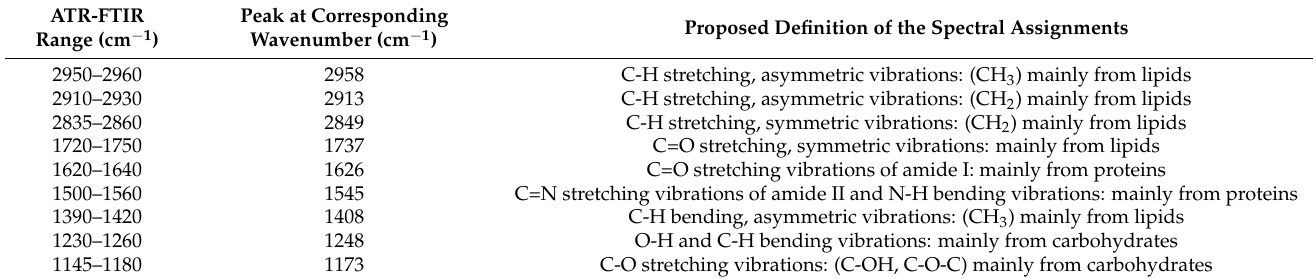
Table 1. Key ATR-FTIR ranges and peaks distinguished by PCA and LDA analysis. Peak assignments based on [3,5,25].